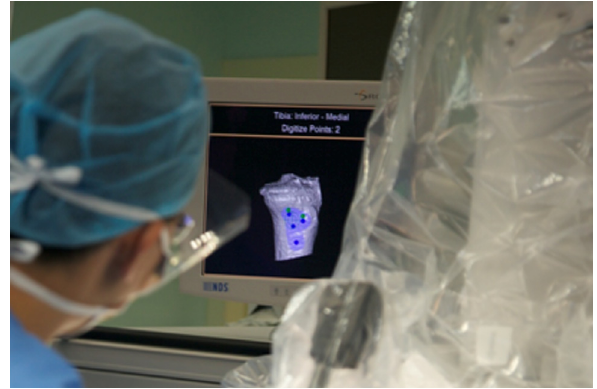
Figure 5. Digitization of tibial landmarks.